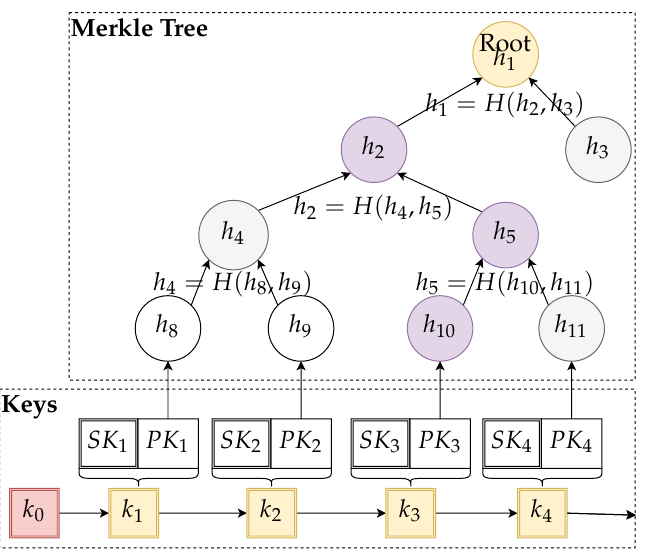
Figure 2. Example of a relevant part of a sequential key structure and Merkle tree authenticator built on top of the precomputed public key